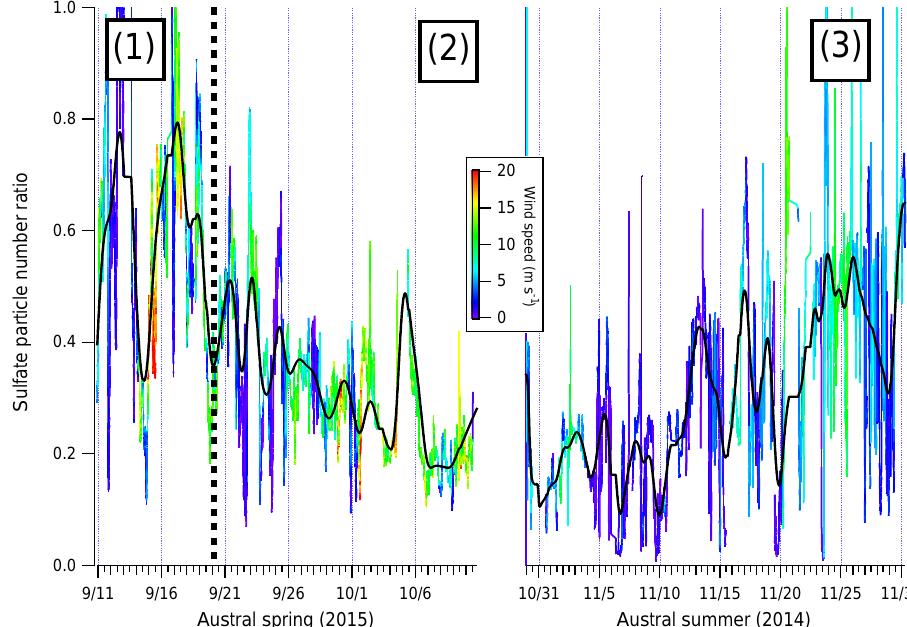
Figure 4. Sulfate number ratio as calculated from the AMS PToF mode divided by the total number concentration from the EPC over both 2014 (right) and 2015 (left). Both field seasons’ data are colored by recorded wind speeds. A smoothed trace of only wind speeds <8ms − 1 is overlaid in black. Rough timing for the phases discussed in Sect. 3.2 are